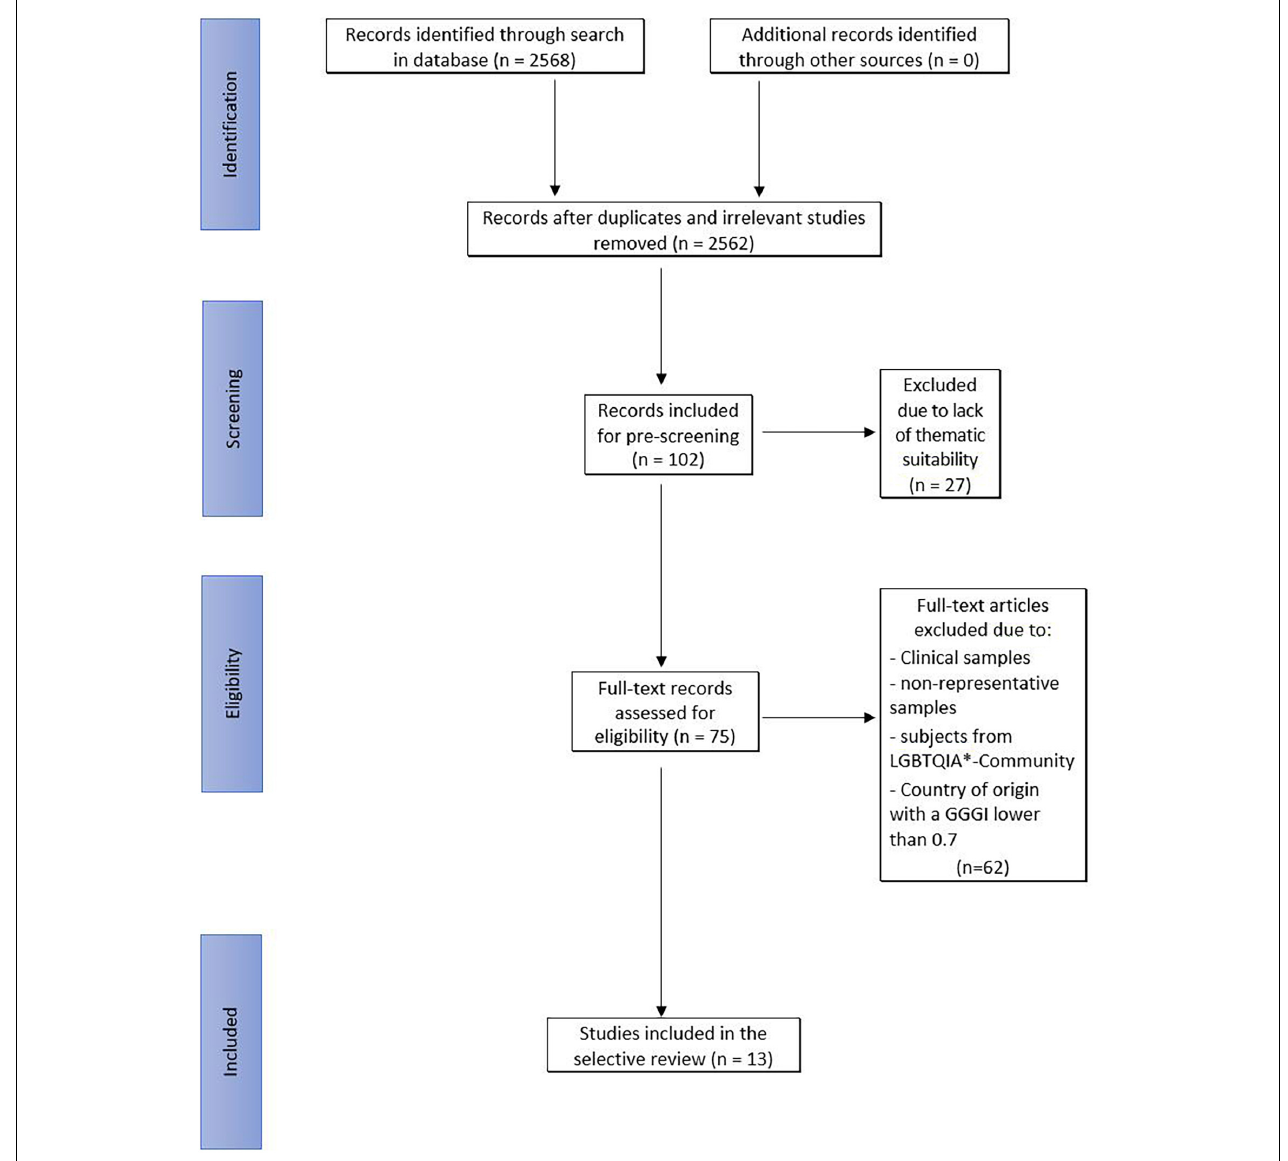
FIGURE 1 | Flow diagram of the selective review according to Page et al.